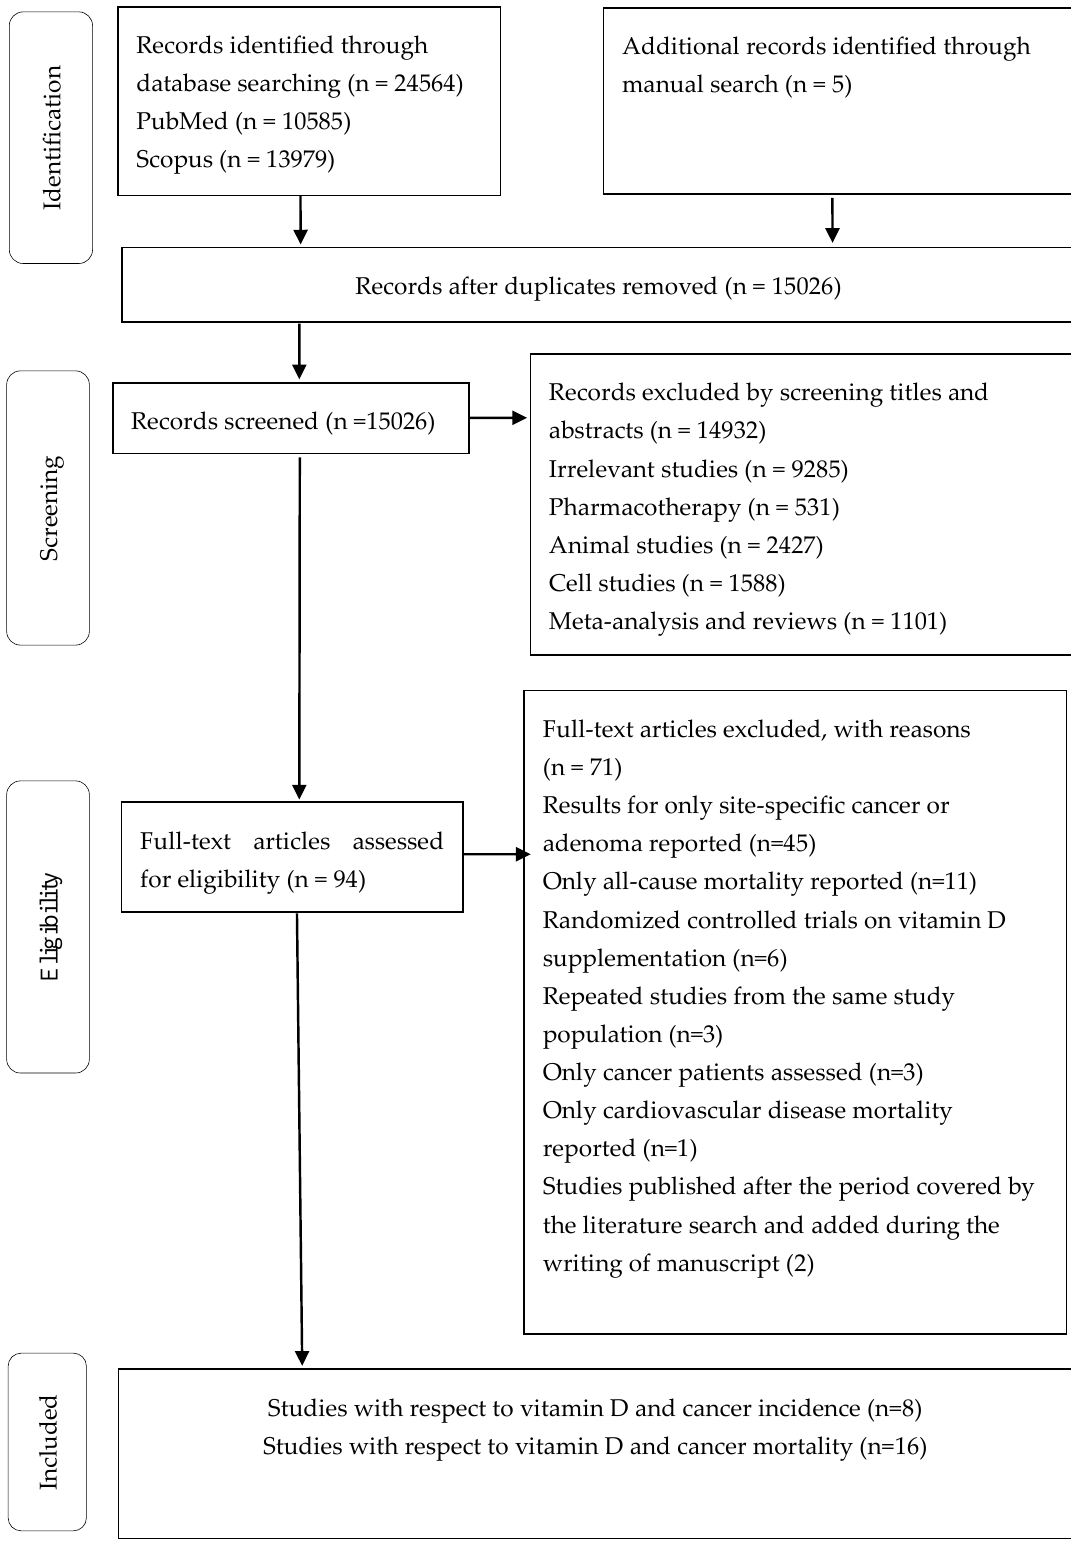
Figure 1. Flow chart of the study selection process.